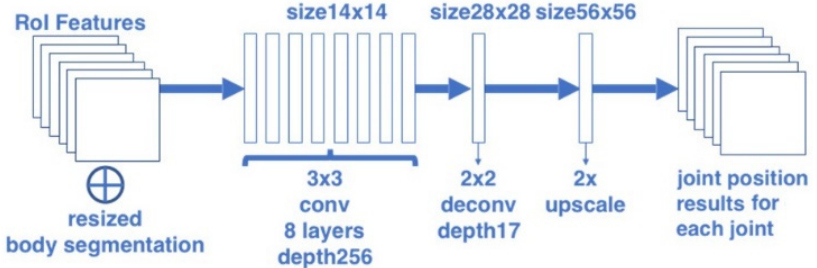
Figure 9. Joint position estimation branch combined with body segmentation (for Figure 8a).